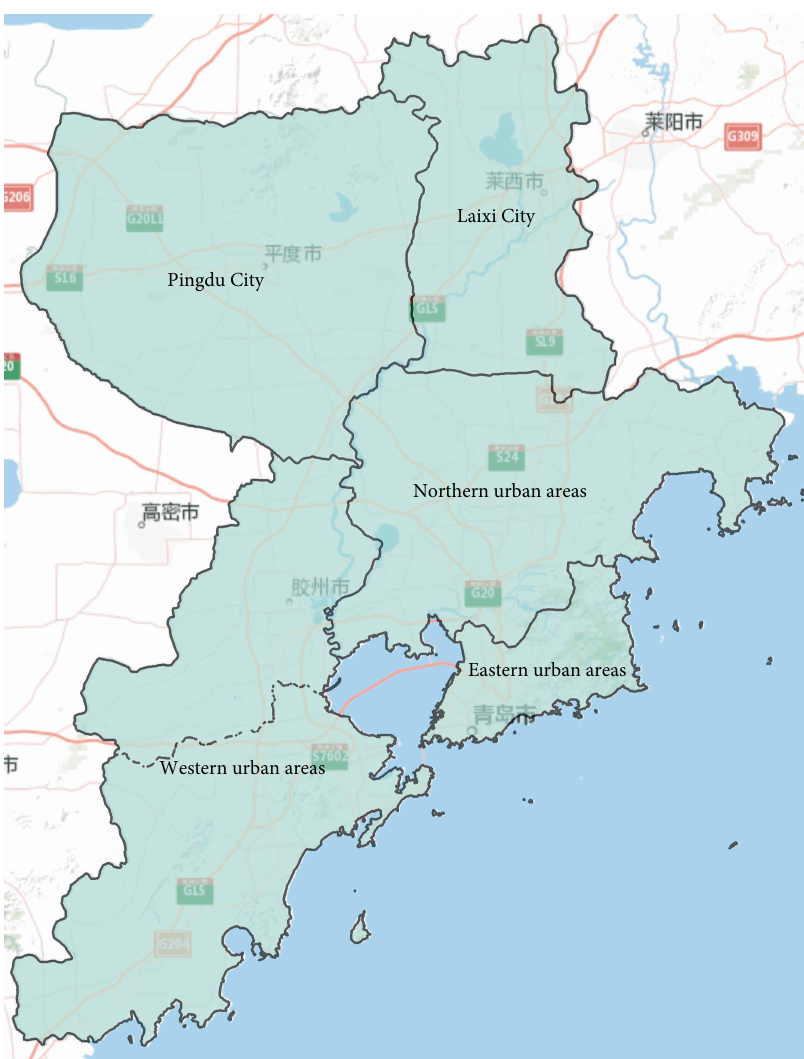
Figure 2: Urban areas of Qingdao